Question: Which visualization type does this figure use?
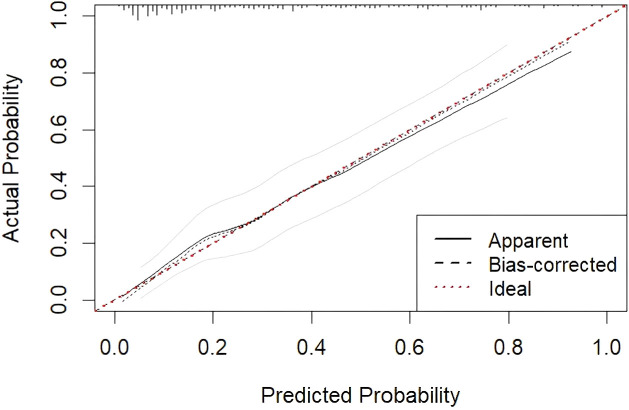
Answer: line